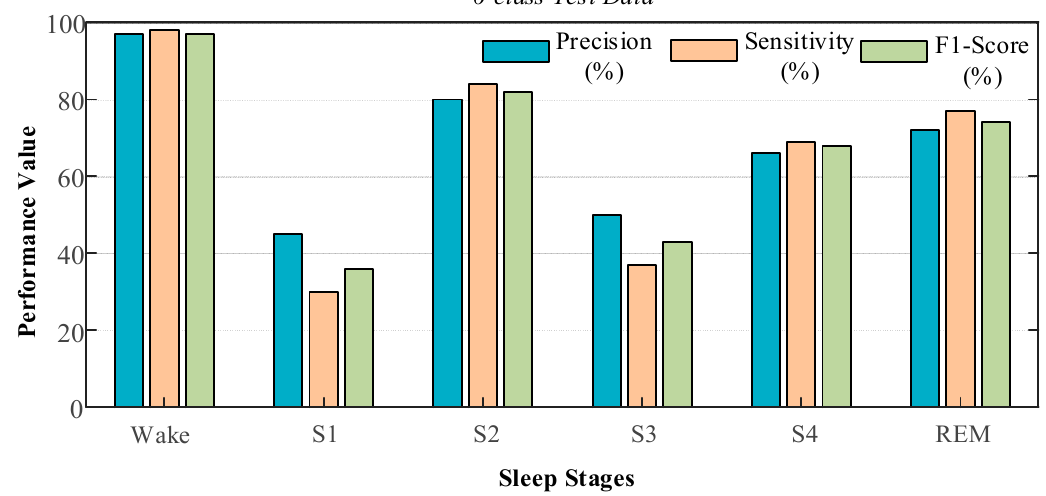
Figure 10. Graphs of performances obtained using the six-class testing data.